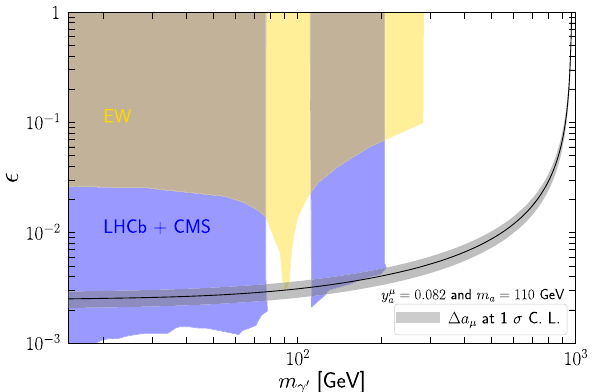
Fig. 5 The allowed region for explaining the muon g − 2 with the fixed μ = 0 . 082 and m = 110 GeV at 1 σ CL ALP parameters y a a